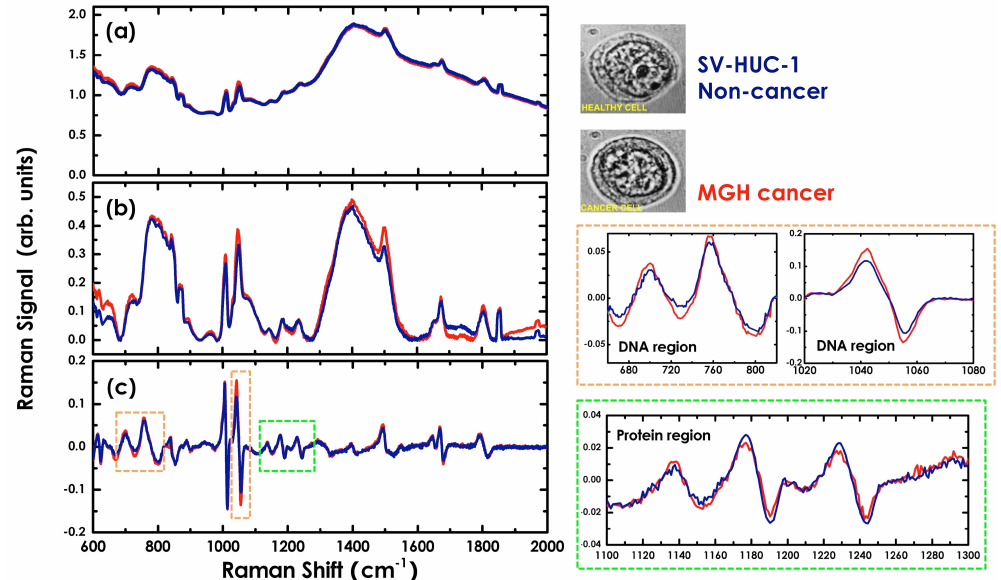
Figure 6. Mean spectra of normal (blue) and bladder cancer cells (red line) acquired with standard Raman spectroscopy ( a ), after polynomial baseline subtraction ( b ) and with modulated Raman spectroscopy ( c ). A zoom in the spectral regions between 660 and 820, 1020 and 1080 and 1100 and 1300 cm − 1 , for modulated Raman spectra, is also shown [65]. Table 2. Band assignment for the wavelength-modulated Raman spectra of SV-HUC-1 and MGHcells